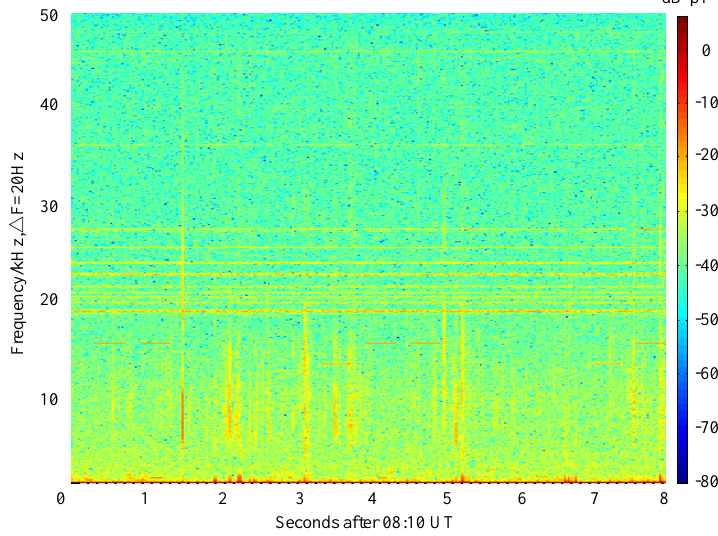
Figure 6. Spectrogram of the atmospheric